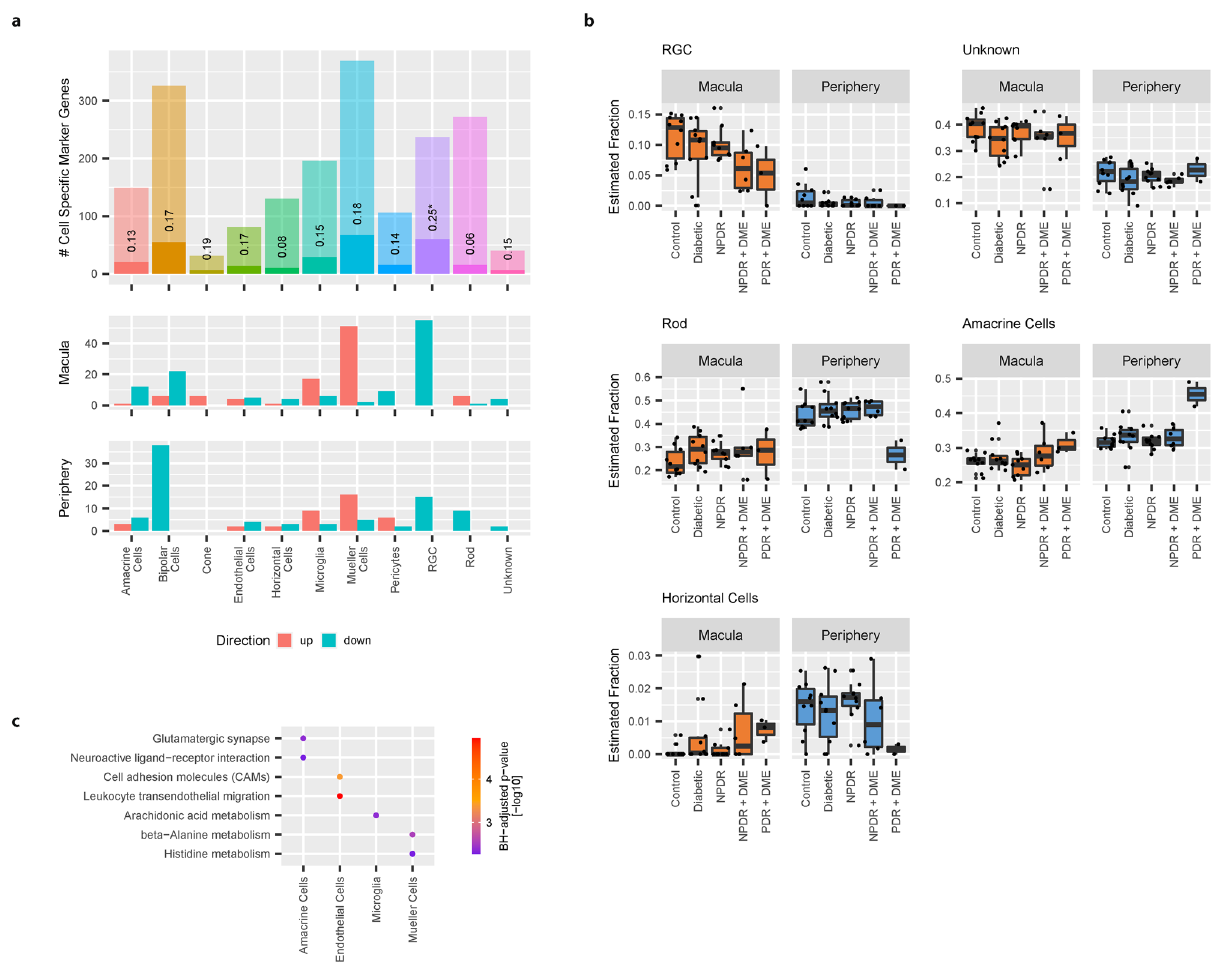
Figure 6. Cell specific expression of disease-associated RNA: ( a ) Enrichment of disease-associated genes with cell type specific genes identified from single cell RNASeq data. Barplots indicate the number of cell type specific marker genes identified for each cell type (upper panel). Non-transparent area of bars show the overlap of disease-associated genes (union of DE and DP genes from macula and periphery) with cell type specific marker genes. Middle and lower panel correspond to the direction of expression changes in NPDR/PDR + DME samples vs healthy controls of disease-associated genes (Middle panel: Macula; Lower panel: Periphery). ( b ) Estimation of cell type abundances from bulk retinal samples using deconvolution. Black dots show predicted fraction of different cell types in each of the bulk retinal samples. Black line indicates the median fraction of different cell types in each disease group. Boxplot lower and upper hinges correspond to the first and third quartiles respectively. Whiskers extend to the largest cell type fraction no further than 1.5 interquartile range from the hinge. Outliers are shown in transparent gray. ( c ) Enrichment of cell type specific disease-associated genes with molecular pathways. Plot shows significant (Hypergeometric test, BH-adjusted p value < 0.01) associations between cell type specific disease-associated genes and KEGG 2016 pathways. Color indicates BH-adjusted p values [−